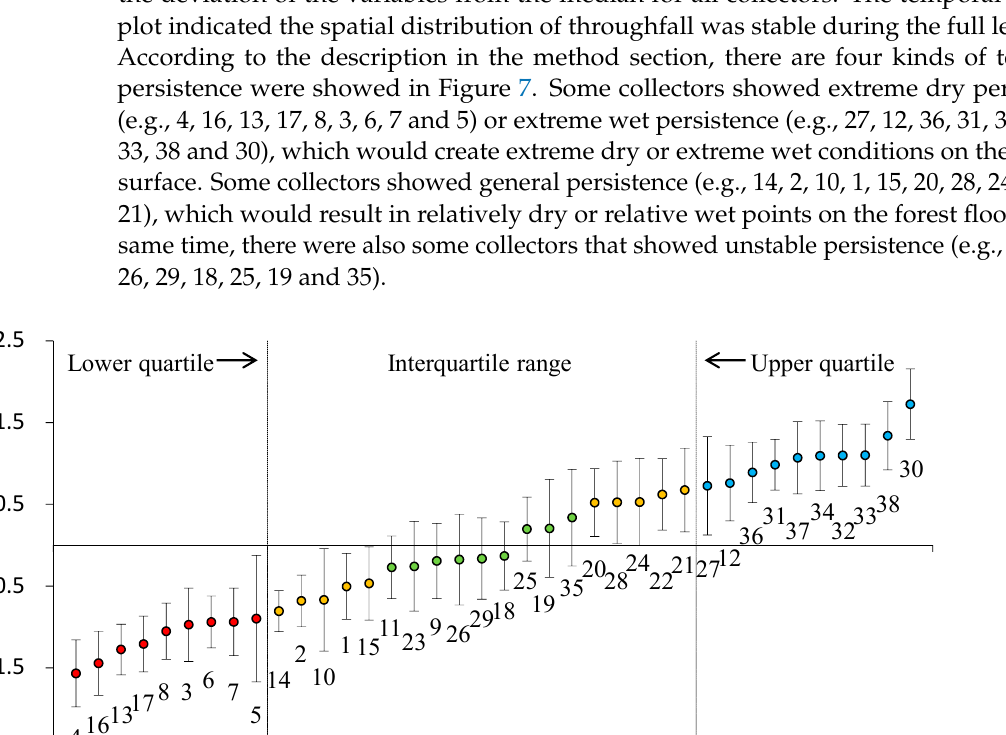
Figure 6. Coefficient of variation of throughfall (throughfall CV CS ) as a function of distance from nearest trunk ( a ), canopy thickness ( b ), and leaf area index ( c ).